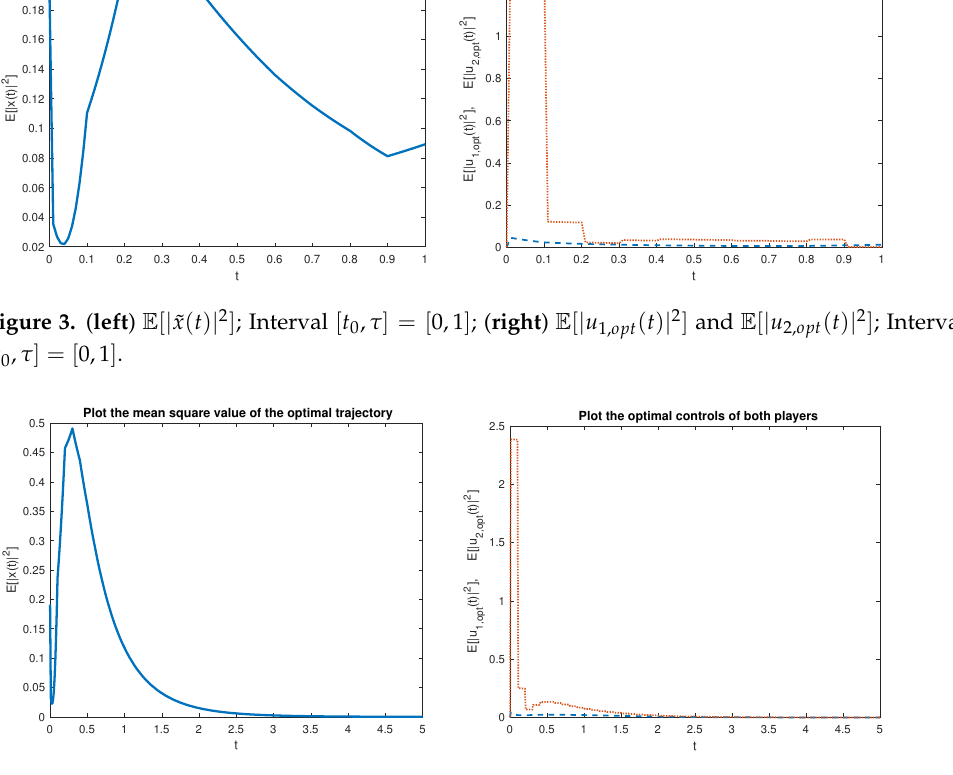
Figure 4. ( left ) E [ | ˜ x ( t ) | 2 ] ; Interval [ t 0 , τ ] = [ 0,5 ] ; ( right ) E [ | u 1, opt ( t ) | 2 ] and E [ | u 2, opt ( t ) | 2 ] ; Interval [ t ] = [ 0,5 ] 0 , τ